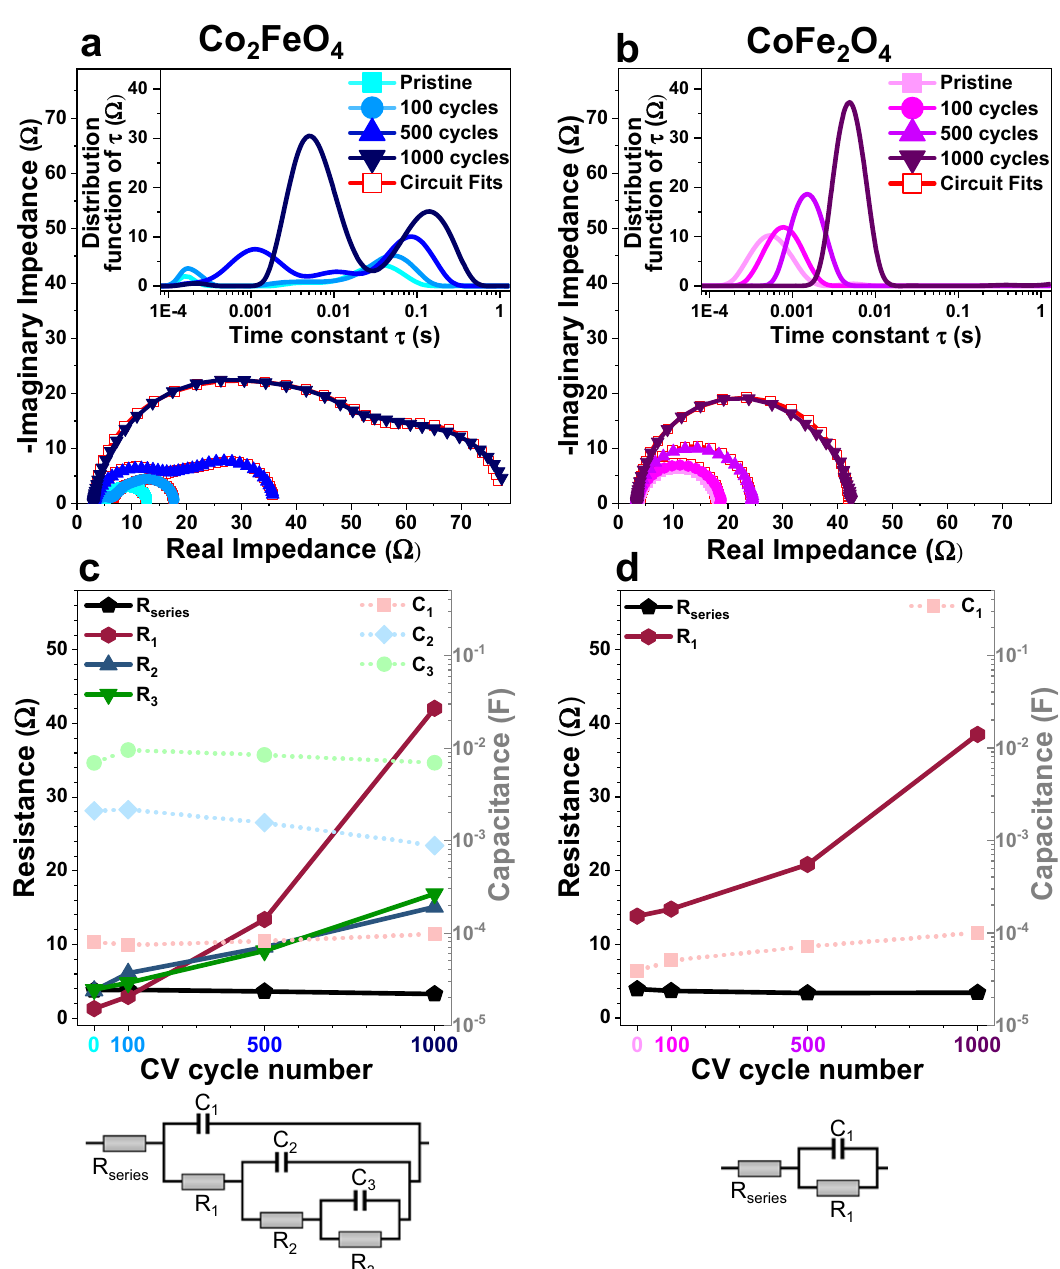
Fig. 7 Electrochemical sub-processes of Co 2 FeO 4 and CoFe 2 O 4 during OER. Electrochemical impedance spectroscopy data in complex plane representation (Nyquist plot) and determined distribution of relaxation times (insets) of electrodes covered by a Co 2 FeO 4 nanoparticles at 1.63 V vs. RHE ( ≈ E LSV,initial (6 mA/cm 2 geom )) and b CoFe 2 O 4 nanoparticles at 1.73 V vs. RHE ( ≈ E LSV,initial (6 mA/cm 2 geom )) in the pristine state and after 100, 500 and 1000 cycles. c , d Corresponding changes of the resistances (solid lines) and capacitances (dashed lines) as the number of CV cycles increases (obtained by equivalent circuit fi tting to the displayed model circuits). Source data are provided as a Source Data fi